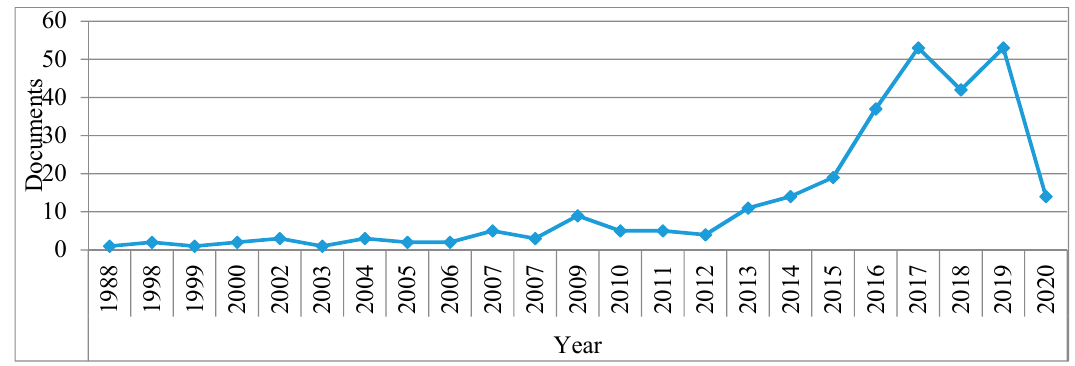
Figure 2. Listed in Scopus research documents on 3D printing of textiles [20] (source: Scopus, key word: 3D printing of textiles). Remark—the real number of not listed in Scopus publications, web reports, conference papers and else is significantly larger.